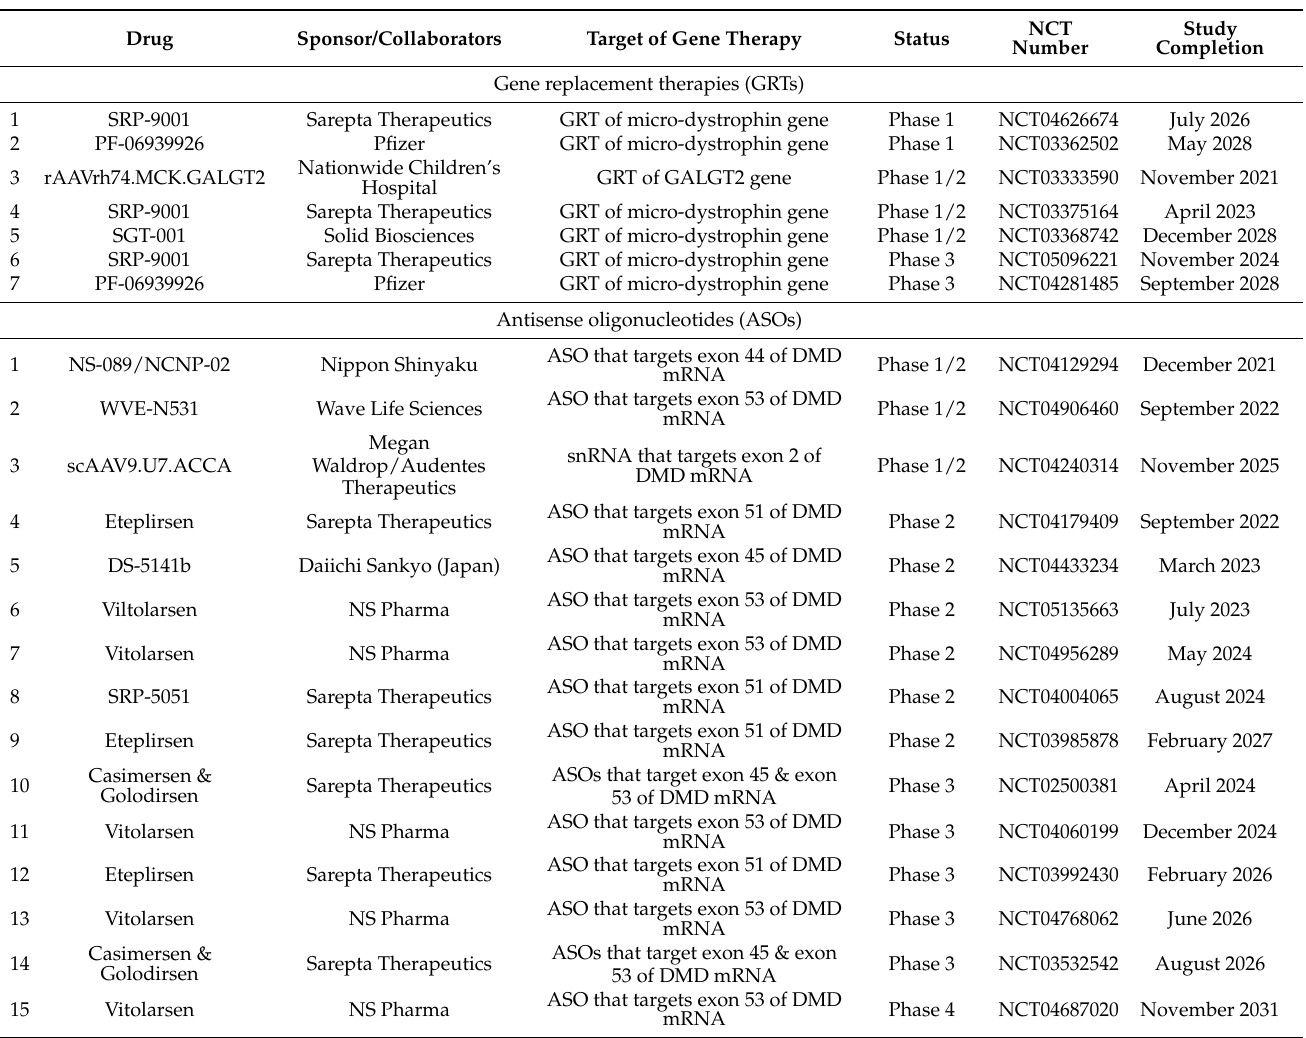
Table 3. Gene-specific therapies for DMD tested in clinical